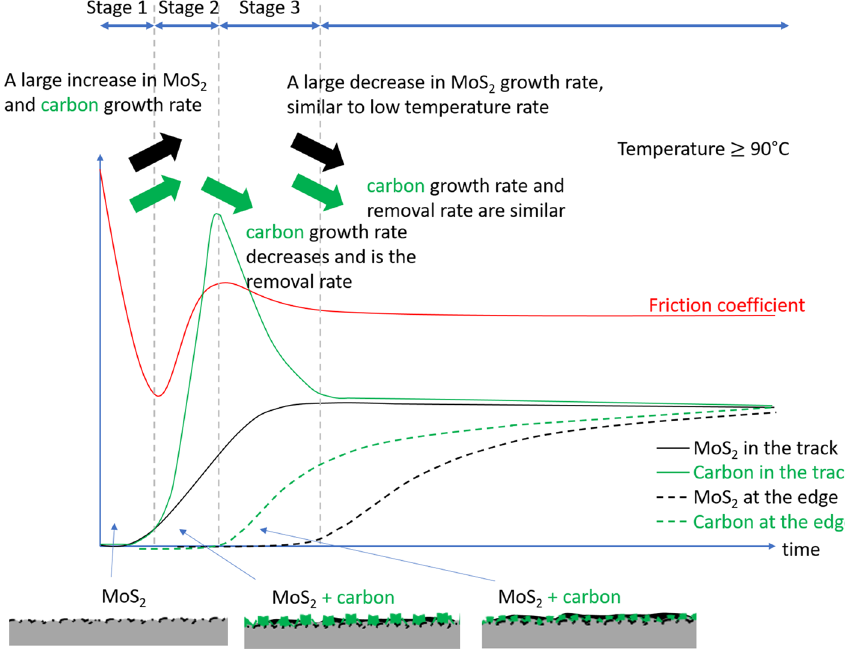
Figure 13. Schematic representation of the variation in friction and Raman signal over time during a high- temperature (> 90ºC